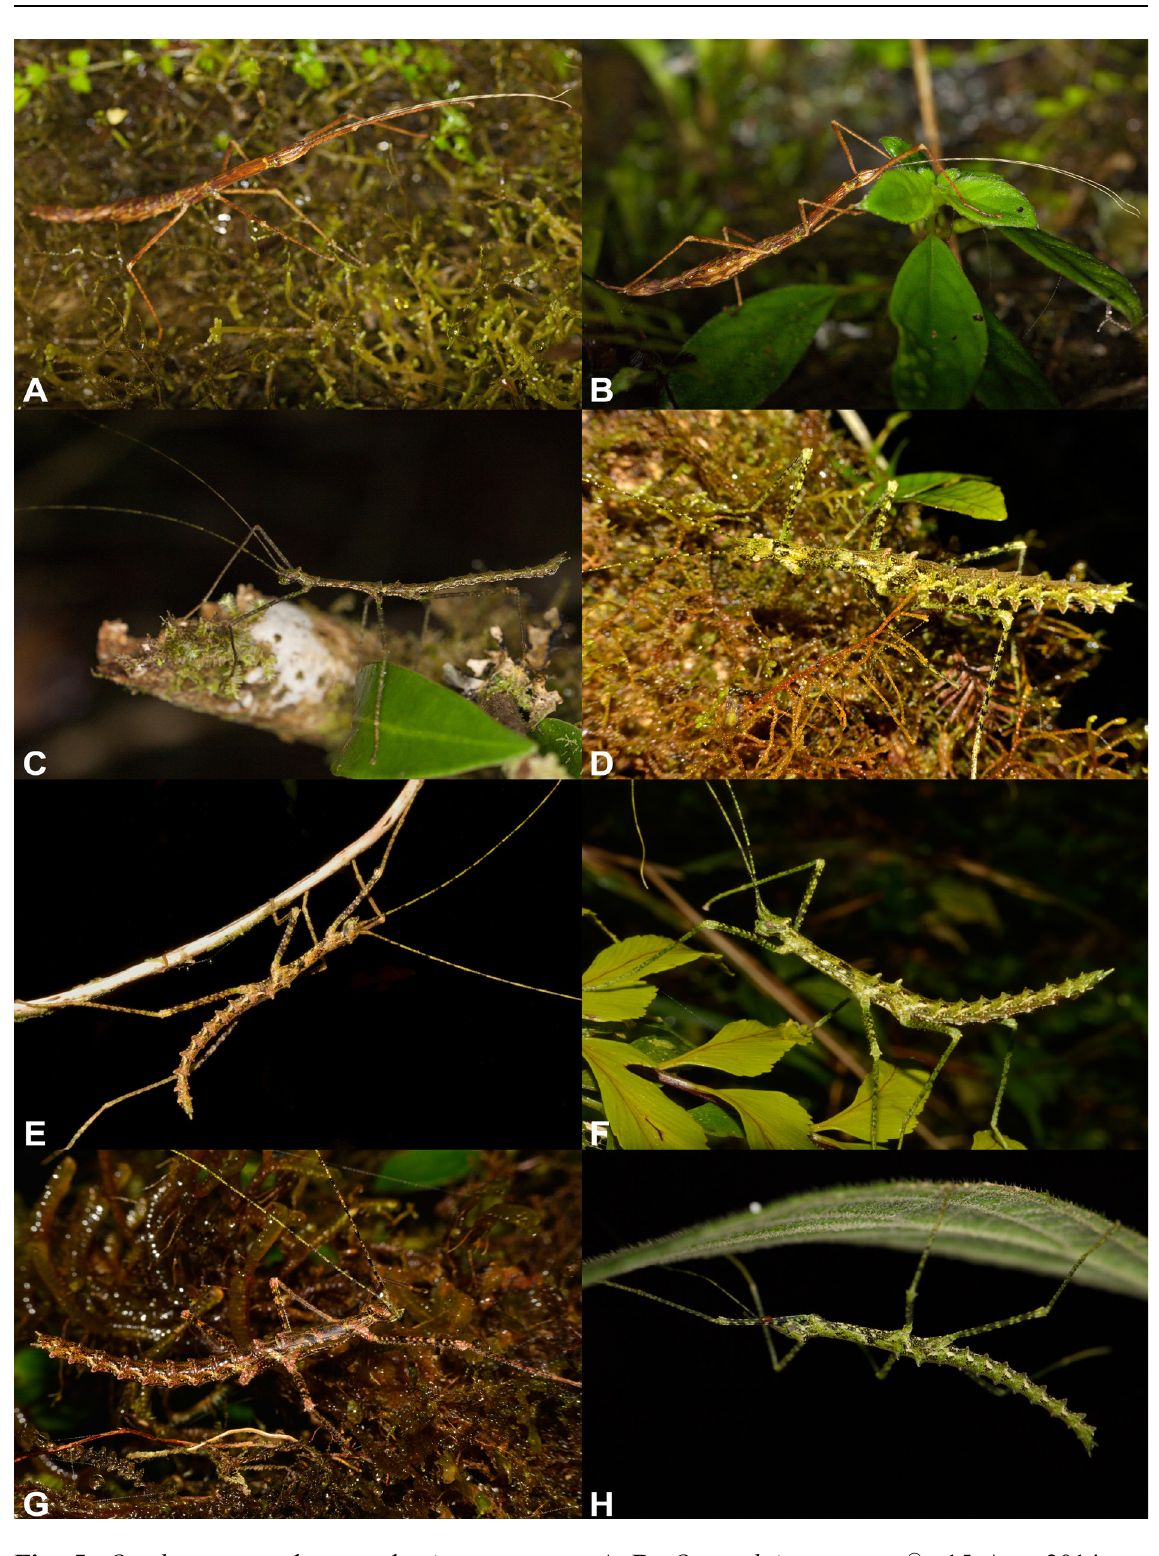
Fig. 5. Otraleus spp., photographs in natura . — A–B . O. applai sp. nov., ♀, 15 Apr. 2014.